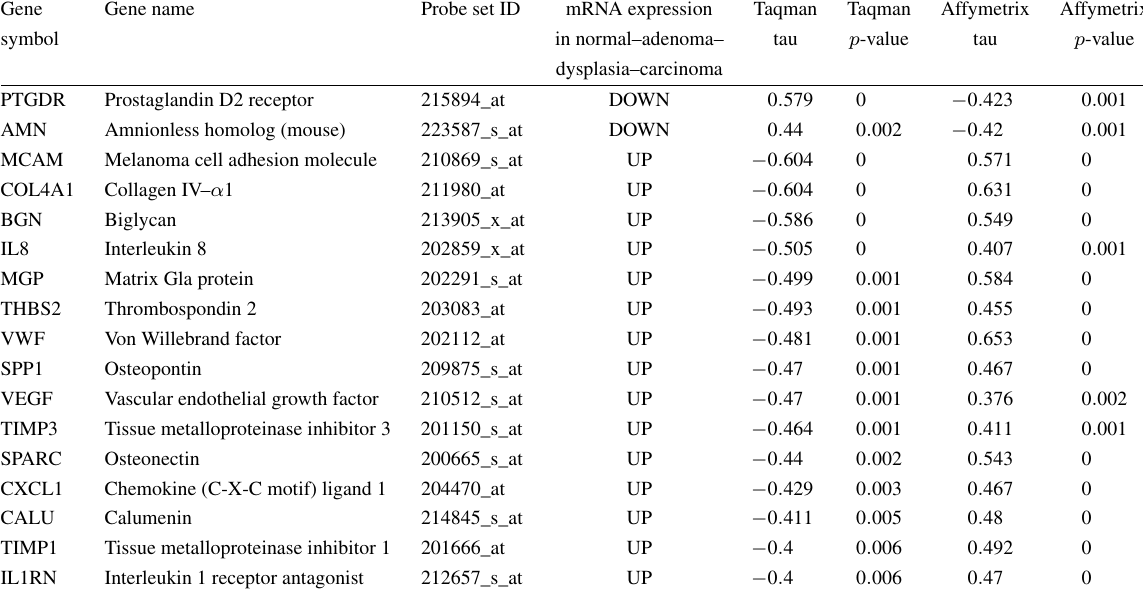
Genes showing a continuous progressively increasing or decreasing expression tendency along with the adenoma–dysplasia–carcinoma sequence